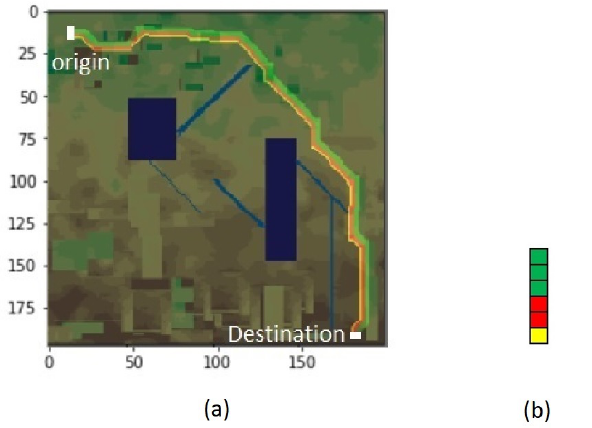
Figure 18. Subfigure ( a ) shows the LCP found by the MLTG method. Subfigure ( b ) is the desired arrangement of an LR neighborhood of the corridor, with the highway being on top, the powerline in the middle, and the railway at the